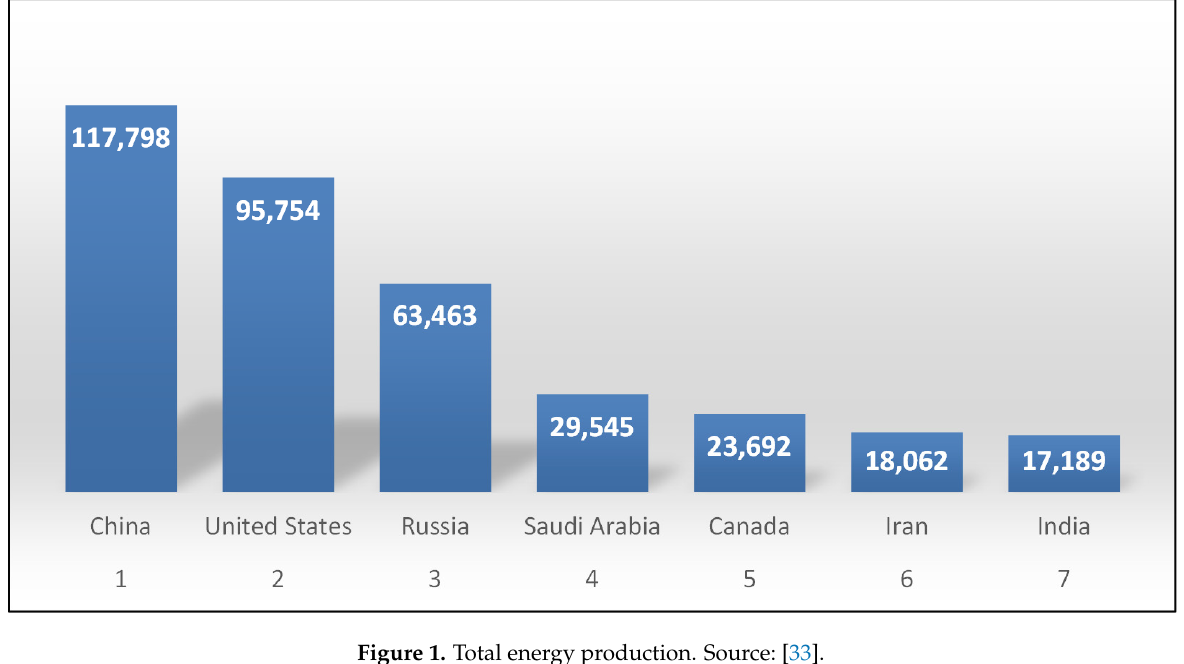
Figure 1. Total energy production. Source: [33].